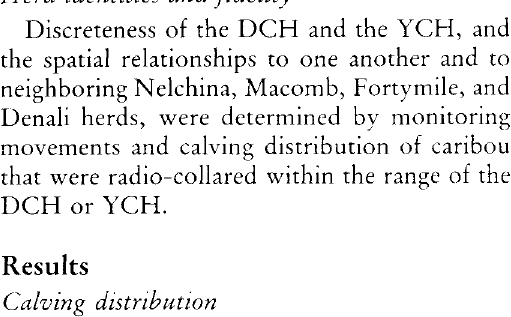
Fig. 1. Study area and distribution and calving areas of the Delta and Yanert Caribou